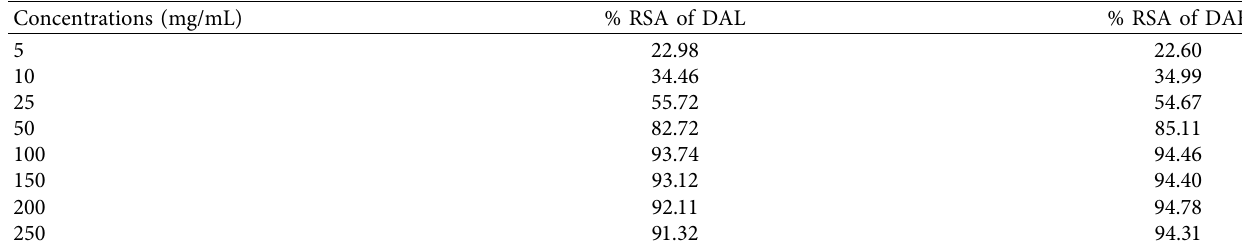
Table 6: % radical scavenging activity.